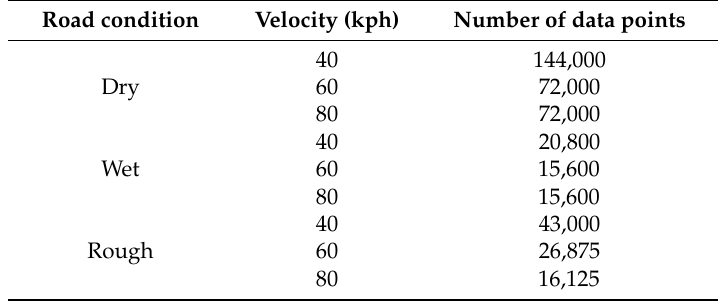
Table 1. Number of acceleration data points measured while driving in the proving ground (PG).